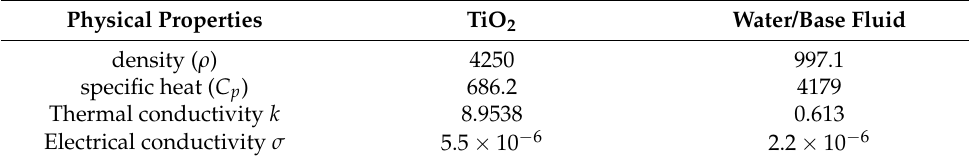
Table 1. Thermophysical properties of nanoparticles (TiO 2 ) and base fluid water [32,33].